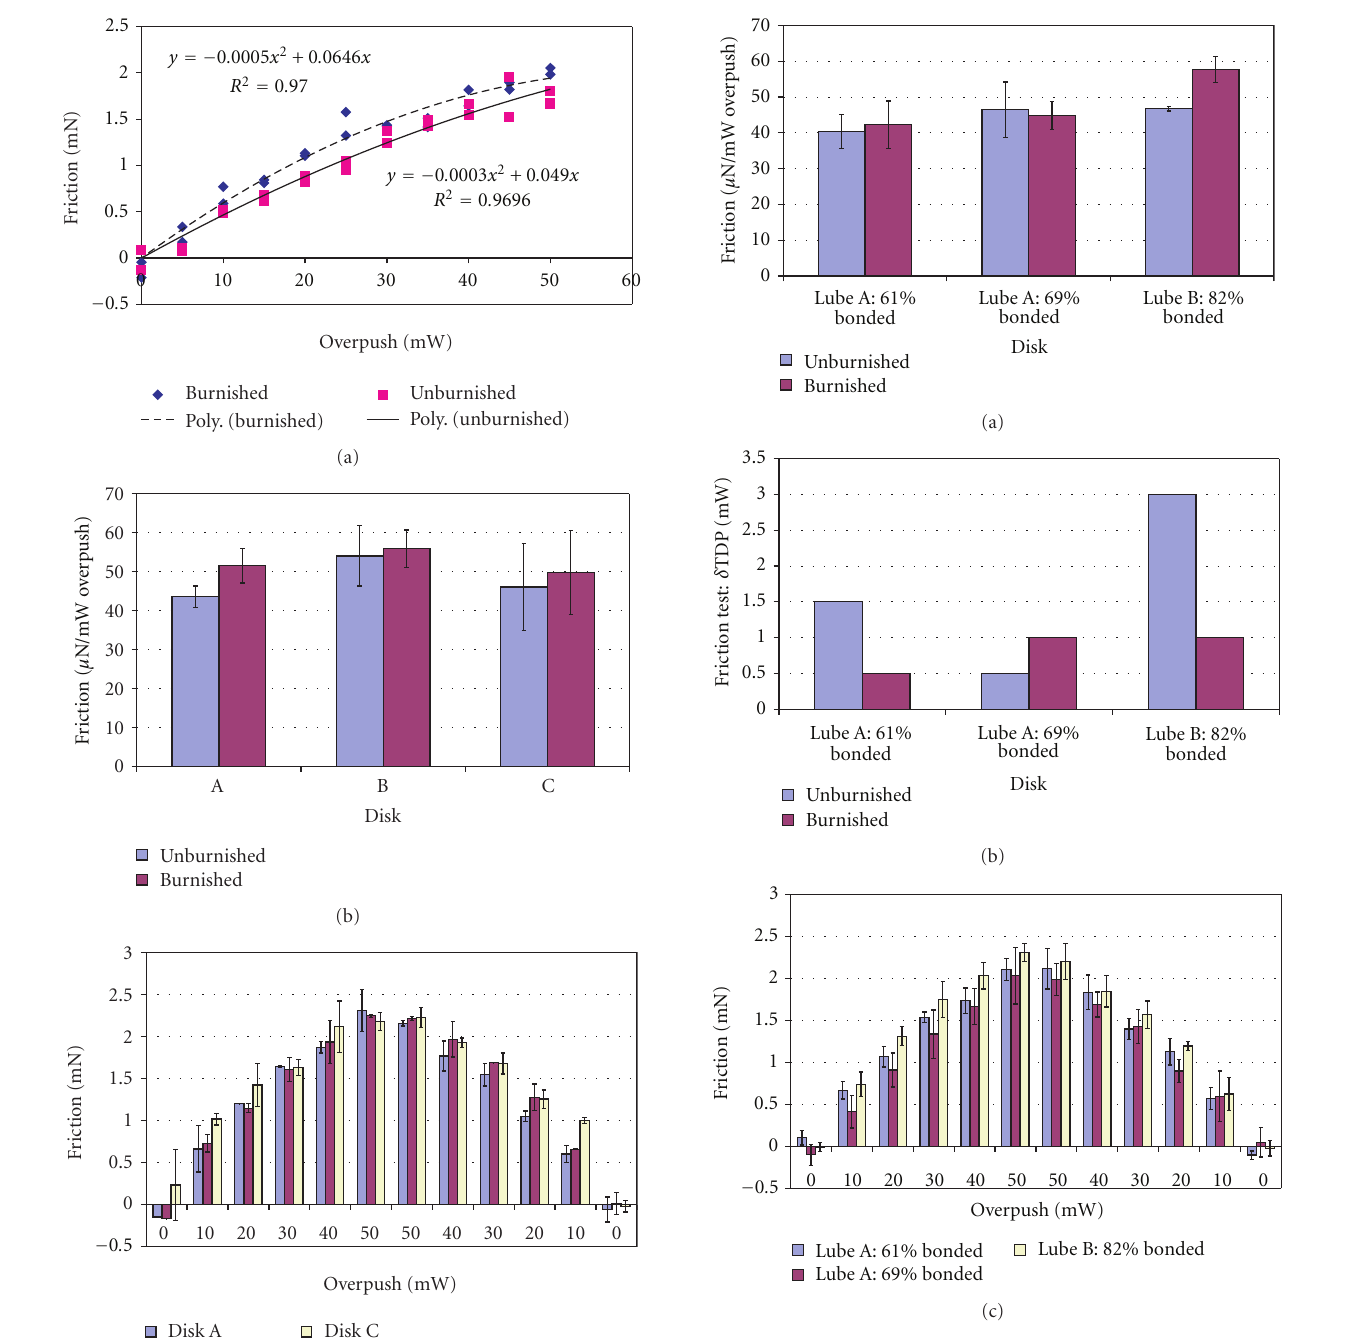
Figure 11: E ff ect of lubricant parameters on friction and slider bur-